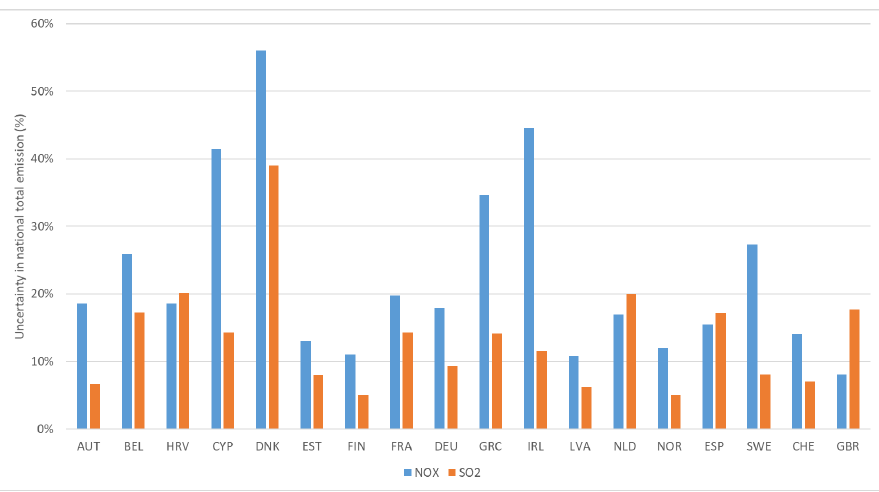
Figure 12. Uncertainties in total emissions of NO x and SO 2 as reported in the Informative Inventory Reports submitted by the countries in 2020 (data taken from Schindlbacher et al.,